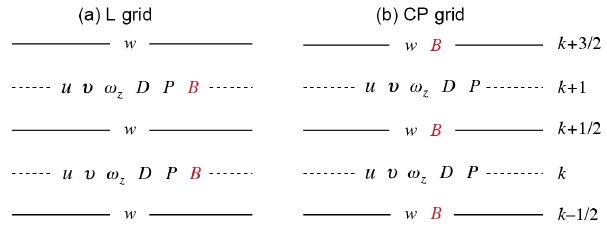
Figure 10. The (a) L and (b) CP grids and the distribution of vari-